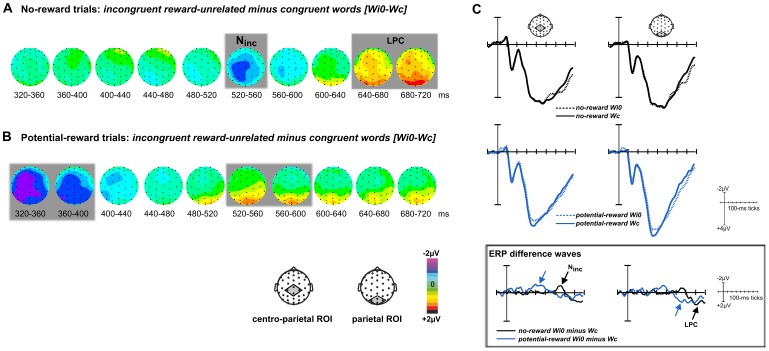
Influences of reward in the relevant dimension on conflict processing.(A) Averaged ERP distribution maps of the difference between incongruent and congruent trials (Wi0-Wc) in no-reward trials reveal the incongruency-related negativity (Ninc) over centro-parietal sites followed by the late positivity component (LPC) over parietal sites. (B) The analogous comparison in potential-reward trials revealed that the Ninc and LPC components were replaced by earlier modulations in the centro-parietal and parietal ROIs. Gray-shaded areas indicate significant mean-amplitude differences in the respective ROIs (p-values<.05). (C) ERP waveforms for each condition as well as the respective ERP difference waves are shown for selected ROIs (averaged across channels).